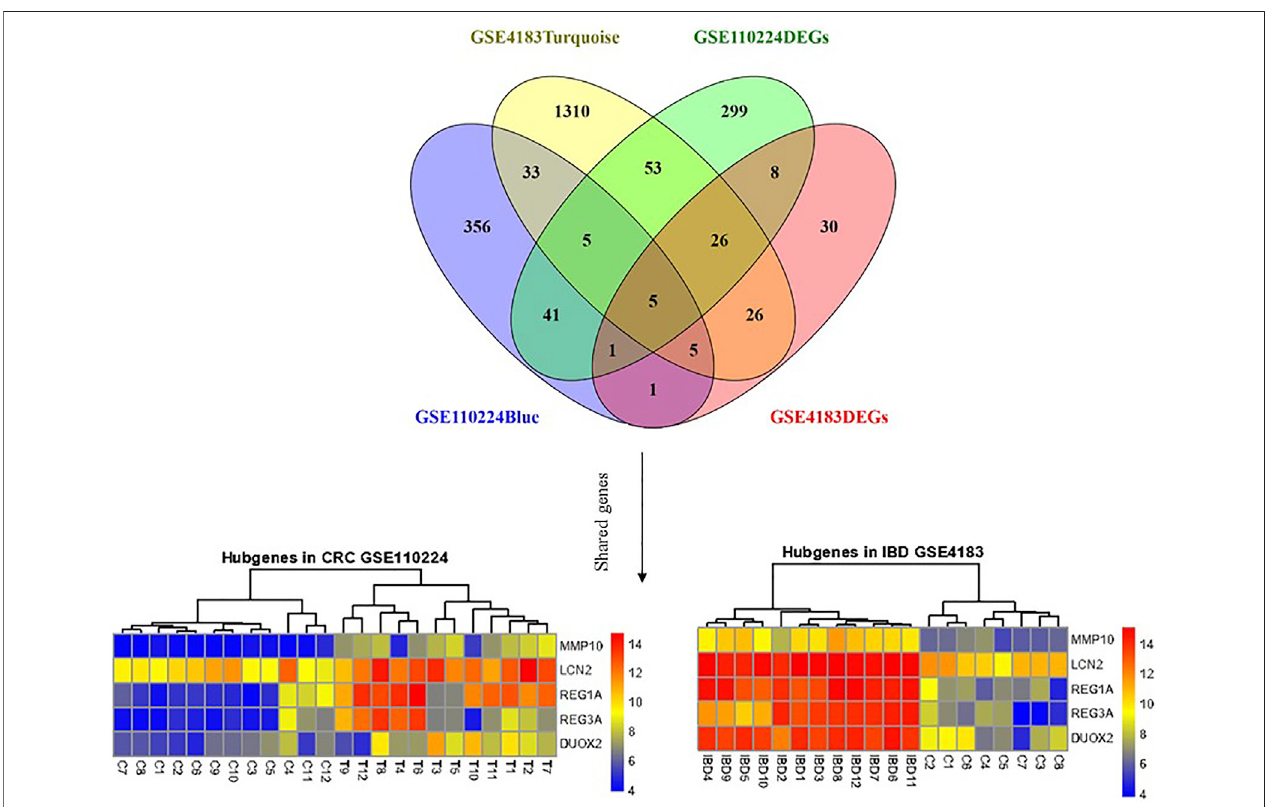
FIGURE5| Shared gene expression in CRC and IBD patients compared tonormal controltissues. The leftside shows thevaried expression values between CRC tissues in comparison with adjacent normal tissue, and the right plot illustrates the expression of candidate genes between IBD and corresponding normal control tissues. The upregulated and down-regulated genes are shown as red and blue tiles, respectively.